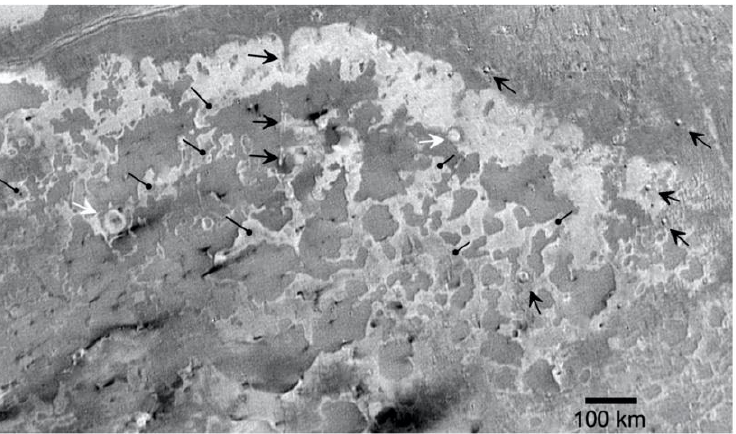
Figure 25. Enlargement of global cylindrical map showing macular southern terrains near the equator of Triton. The terrain consists of dark maculae units of various sizes up to ~100 km across. Between the maculae are bright materials, which are often concentrated around the edges of the patches and form diffuse contacts with a darker substrate exposed between the maculae (smaller black arrows). A few preexisting features are exposed within this dark substrate (a narrow fracture [dark arrows] and two apparently degraded craters at the left and near center [white arrows]) that may have been exhumed when the patches formed by scarp retreat. North is